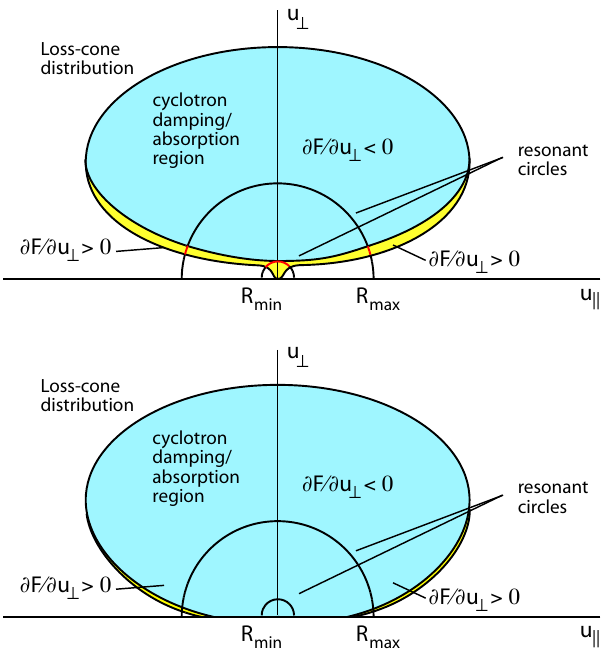
Fig. 5. Same as in Figure 4 except for the modulation of the loss cone included. Top : The modulation due to the electric field drift in the transverse electric field of the ion-cyclotron mode shifts the perpendicular velocity up thereby opening the loss cone and pushing its gradient to higher u ⊥ . This steepens the gradient and reduces the damping part of the resonance circle. At minimum radius (largest emission frequency ν ec ) the resonance circle is fully in the positive gradient. During this phase emission is amplified. Bottom : During this phase the drift reduces the perpendicular velocity filling the loss cone and switching the maser off.